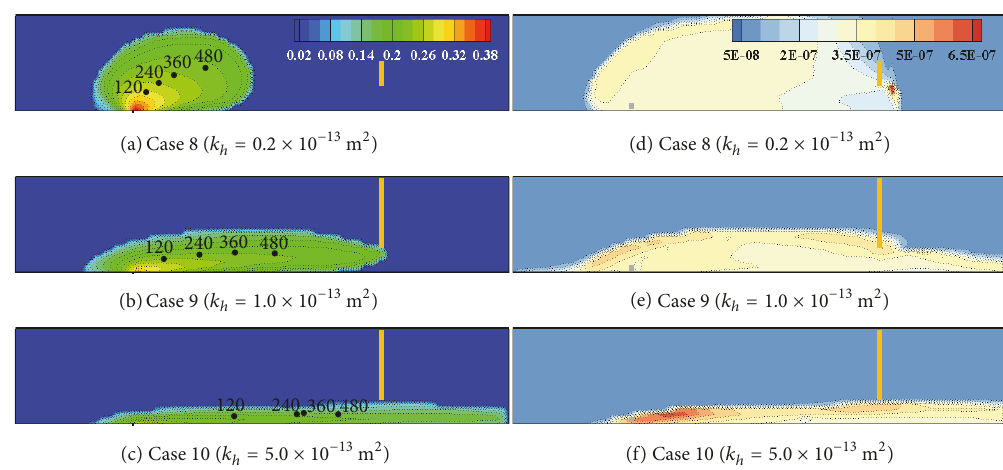
Figure 13: Saturation of leaked CO 2 at different horizontal permeabilities ( 𝑘 ℎ ) after 1 year (365 days). (a) Case 8, (b) Case 9, and Case 10. Black circles with labels indicate the locations of mass center for CO 2 plume. Distribution of ∑ As Concentration induced by leaked CO 2 at different horizontal permeabilities ( 𝑘 ℎ ) after 20 years: Cases 8, 9, and